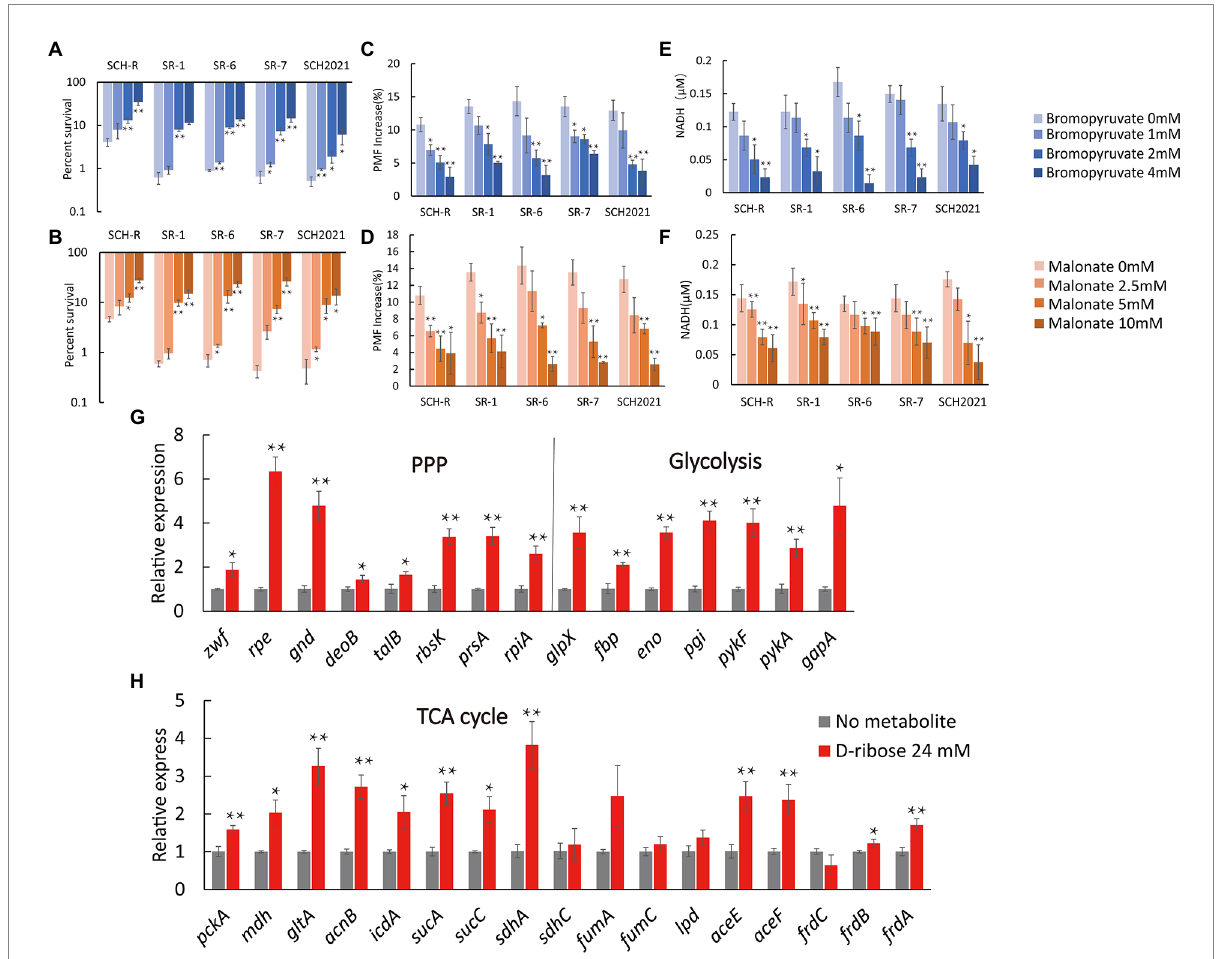
FIGURE 7 Effect of exogenous D-ribose on central carbon metabolism. (A,B) Percent survival of SCH-R and clinical isolates by (A) bromopyruvate and (B) malonate dose and 1 MIC gentamicin plus 24 mM D-ribose. (C,D) PMF of SCH-R and clinical isolates by (C) bromopyruvate and (D) malonate dose with 24 mM D-ribose. (E,F) Intracellular NADH concentration of SCH-R and clinical isolates by (E) bromopyruvate and (F) malonate dose with 24 mM D-ribose. (G,H) QRT-PCR for expression of key central carbon metabolism genes in the presence of 24 mM D-ribose. Results are displayed as the mean ± SEM and three biological repeats are carried out. Significant differences are identified ( *p < 0.05 and **p <